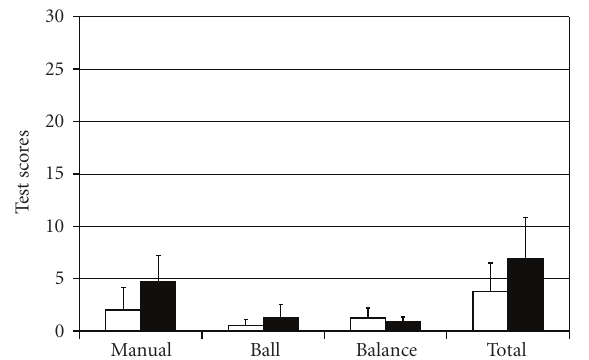
Figure 1: Plot of Movement ABC scores by test subset in children with VEMP present on both sides. White columns = children with normal hearing; Dark columns = HI children.